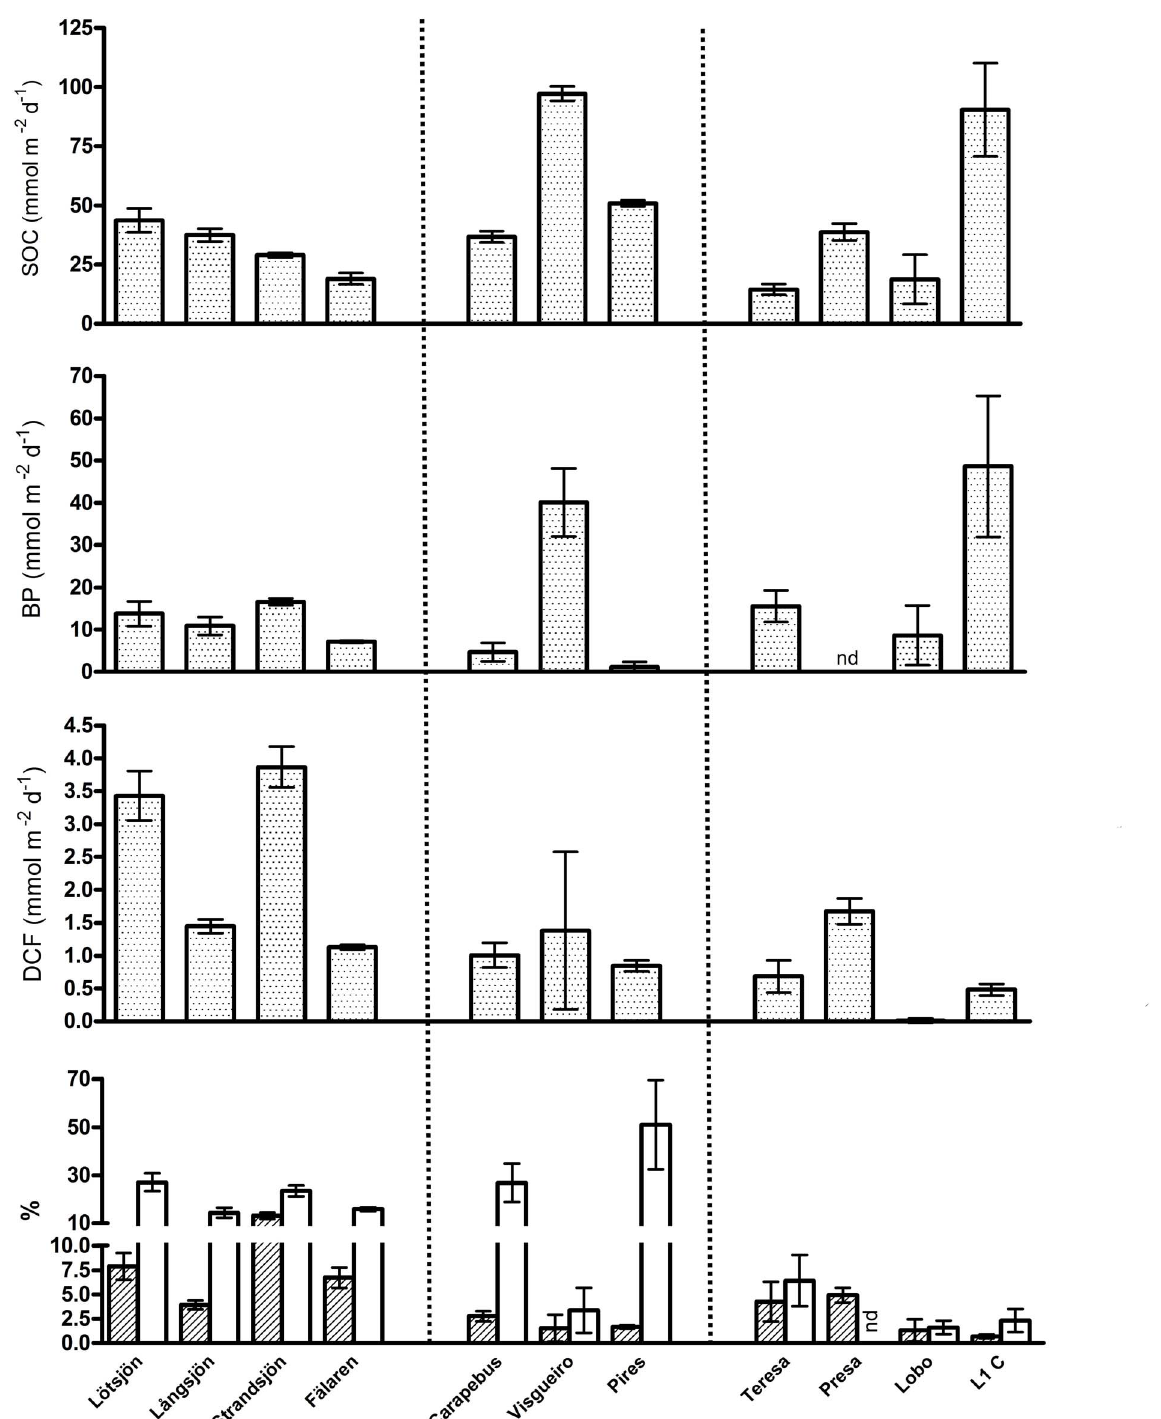
Figure 1. Comparison between measured sediment rates. Rates of sediment O 2 consumption (SOC), bacterial production (BP), dark carbon fixation (DCF) and carbon fixation expressed as a percentage of sediment O 2 consumption (hatched bars, DCF:SOC) and of bacterial production (white bars, DCF:BP) in the surface sediment for all studied lakes. Symbols represent average and plus-minus one standard error.